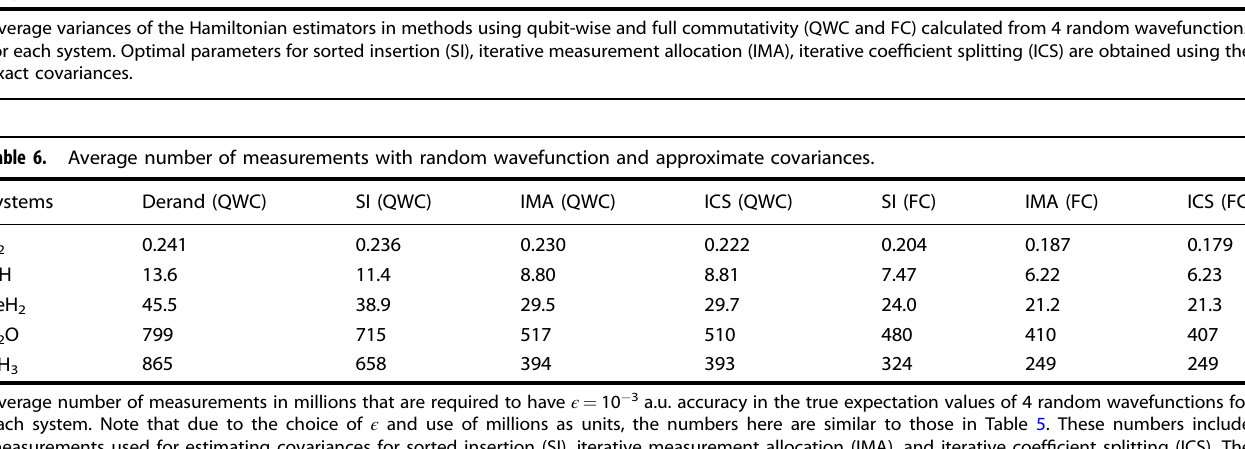
Average variances of the Hamiltonian estimators in methods using qubit-wise and full commutativity (QWC and FC) calculated from 4 random wavefunctions for each system. Optimal parameters for sorted insertion (SI), iterative measurement allocation (IMA), iterative coef fi cient splitting (ICS) are obtained using the exact covariances.